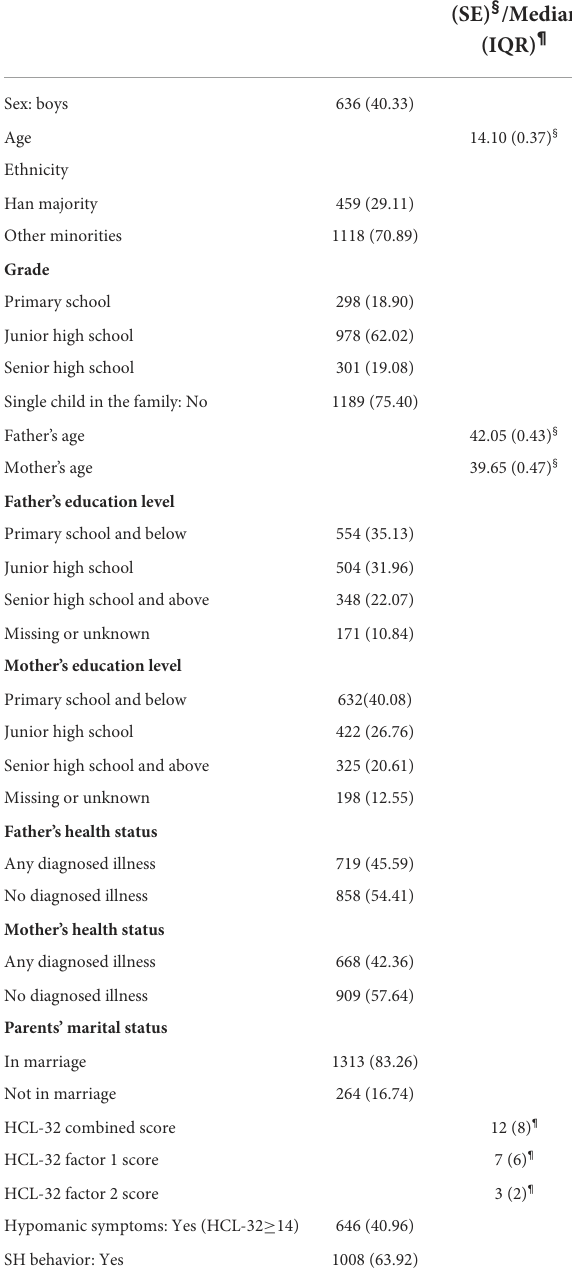
TABLE 1 General features of the study subjects, Kaiyuan, Yunnan, 2020 ( N = 1,577).